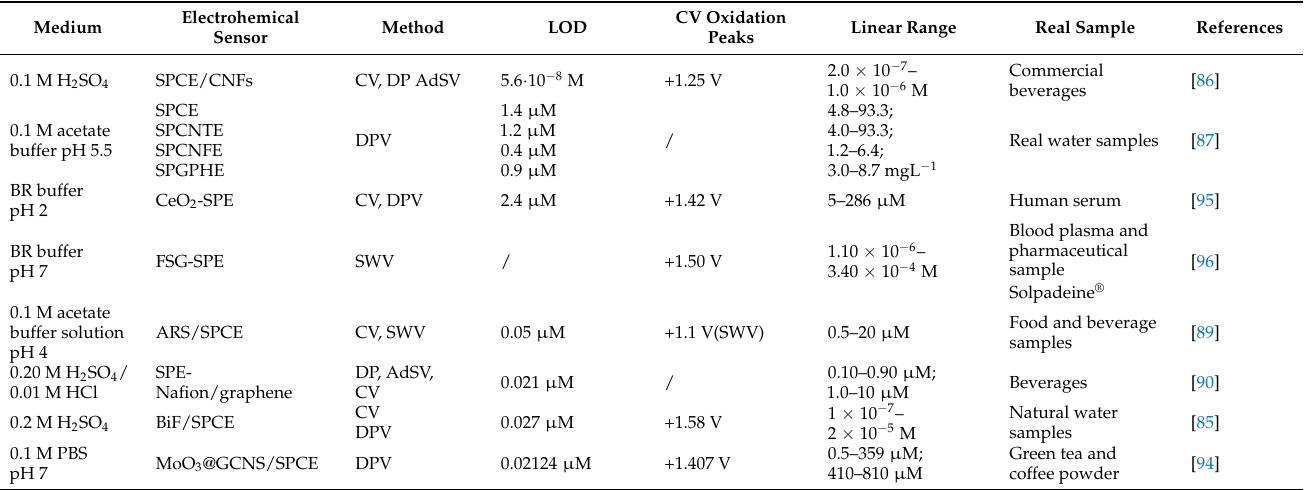
Table 5. Electrochemical characteristics of screen-printed electrodes as sensors for caffeine determina-